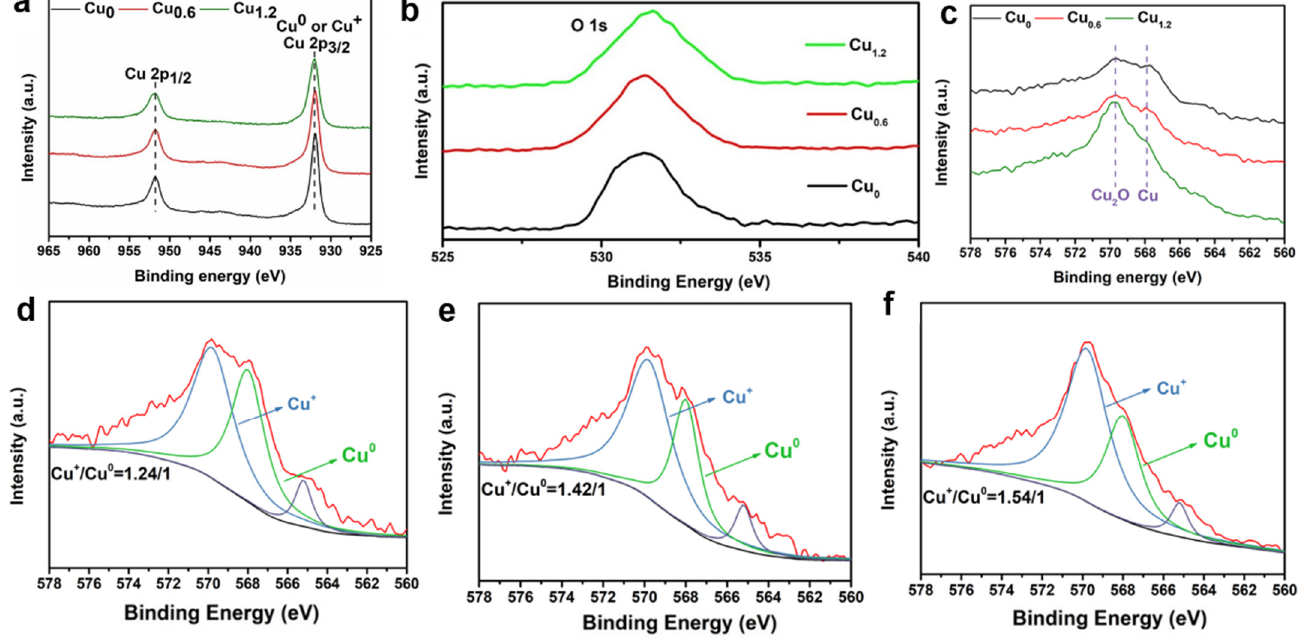
Figure 14. XPS peaks ( a ) Cu 2p and ( b ) O 1s of Cu 0 (black), Cu 0.6 (red), Cu 1.2 (green). ( c ) Cu LMM Auger energy spectra of Cu 0 (black), Cu 0.6 (red), and Cu 1.2 (green) flacking powders. Cu 2p 3/2 split peaks for ( d ) Cu 0 , ( e ) Cu 0.6 , and ( f ) Cu 1.2 .